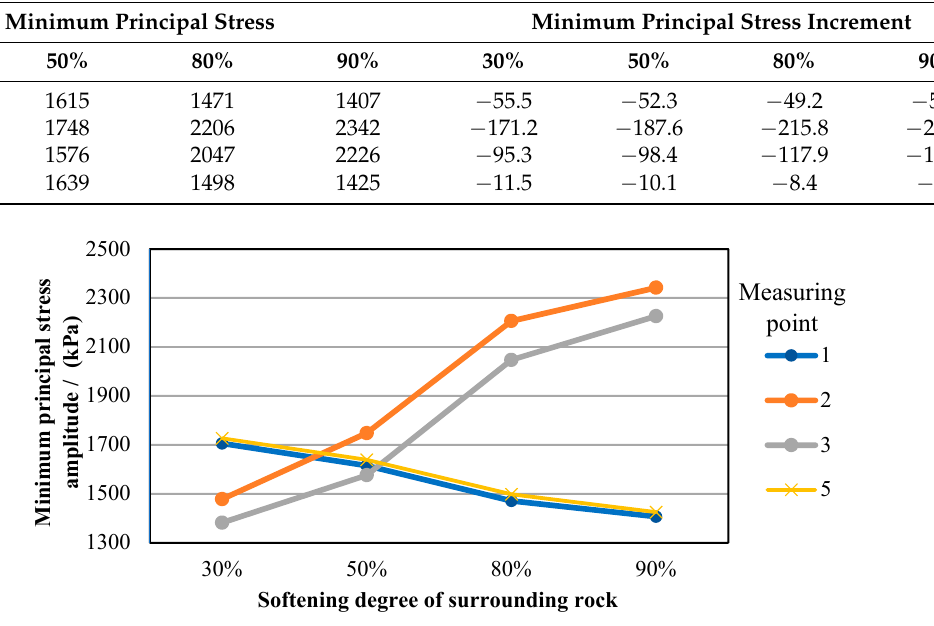
Figure 14. Minimum principal stress amplitude diagram of measuring points 1, 2, 3, and 5 under different softening degrees of basement surrounding rock.